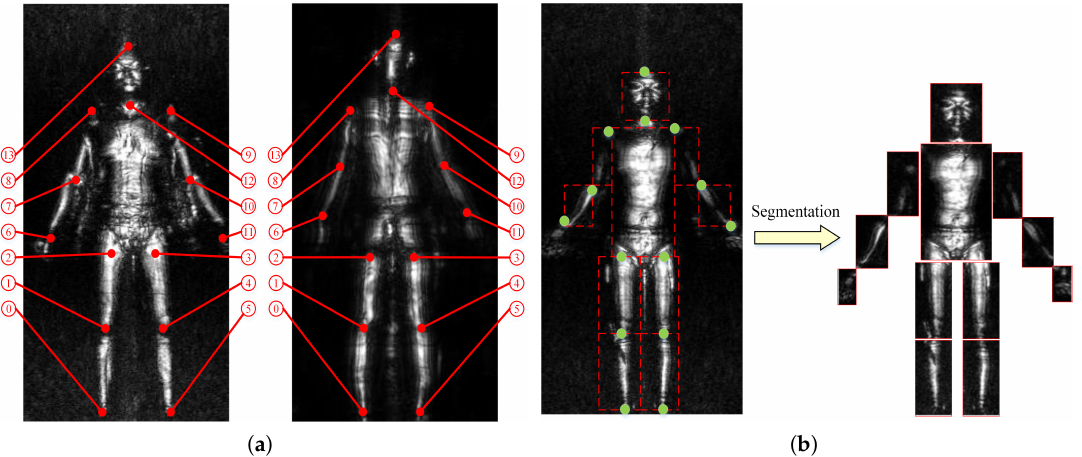
Figure 3. Human image marking and Segmentation rules. ( a ) Human joints marking rules. ( b ) Segmentation of human body image.